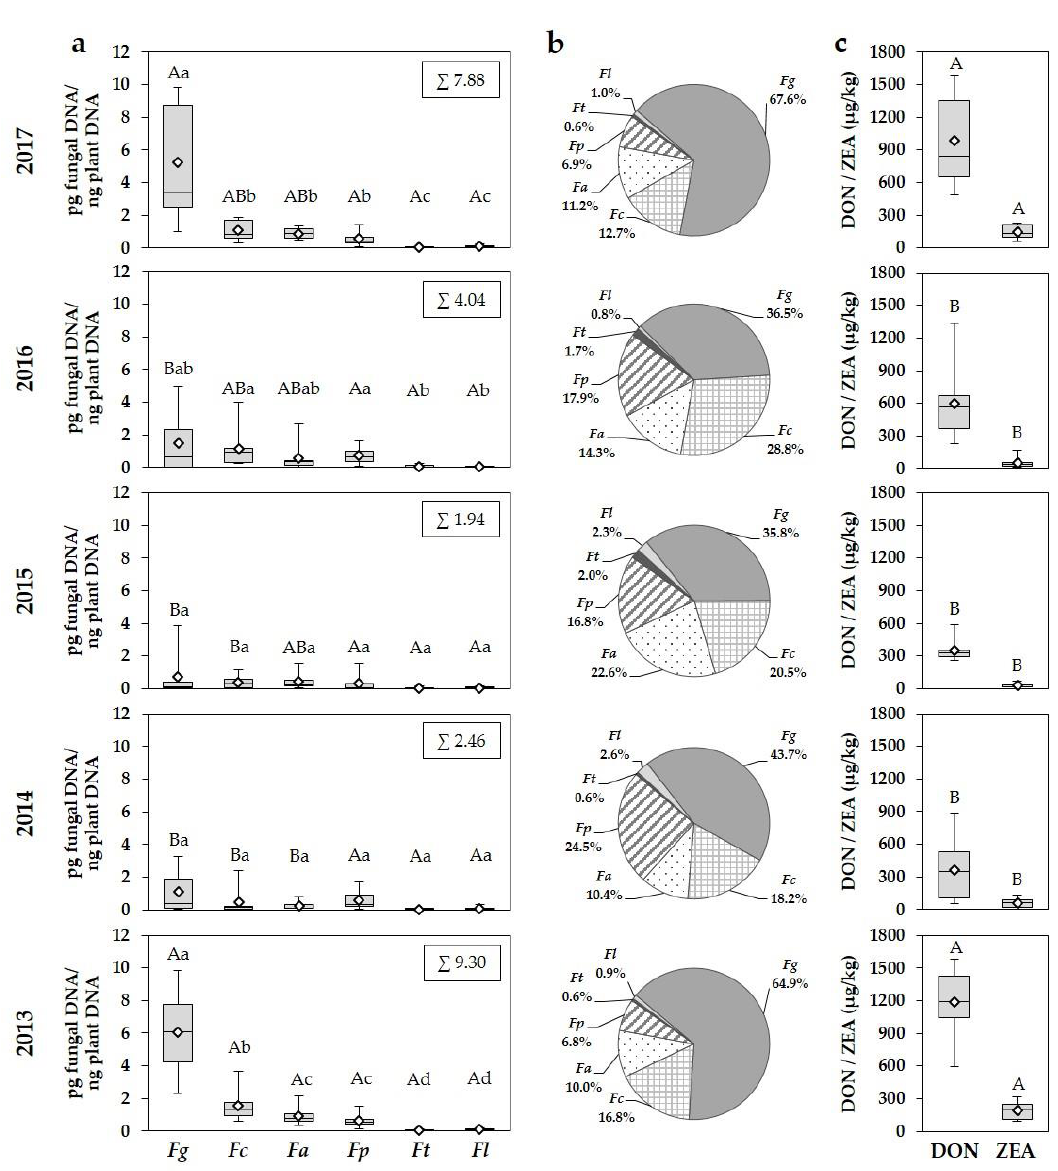
Figure 3. Boxplots and means (white rhombus) of ( a ) DNA amounts of F. graminearum ( Fg ), F. culmorum ( Fc ), F. avenaceum ( Fa ), F. poae ( Fp ), F. tricinctum ( Ft ) and F. langsethiae ( Fl ) (pg fungal DNA/ng plant DNA), ( b ) percentages of DNA amounts of the detected Fusarium species to the total Fusarium DNA amount of all detected species and boxplots and means (white rhombus) of ( c ) DON and ZEA concentrations (µg/kg) in wheat grain of the highly susceptible cultivar of the seven trial locations (three replications per location) in northern Germany from 2013 to 2017. Five statistics are represented in each boxplot from bottom to top: the smallest observation, lower quartile, median, upper quartile, and largest observation, respectively. Mean values labelled with the same letter (small or big) are not significantly different from each other ( p > 0.05). Capital letters describe differences for one species and DON and ZEA concentrations between years and small letters differences between the detected Fusarium species within a year. n = 105.